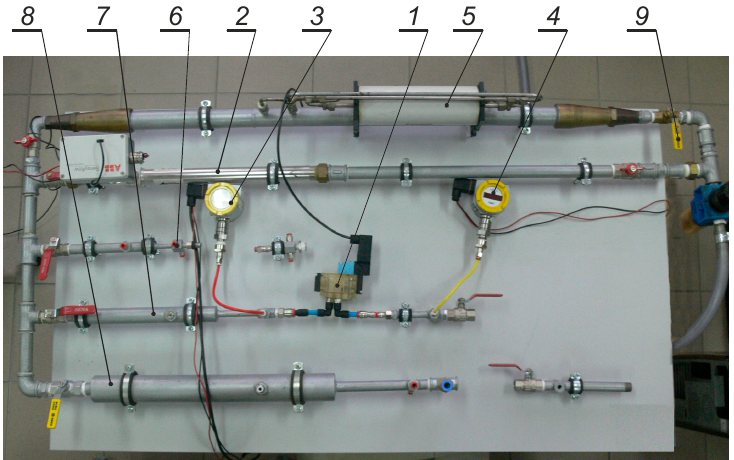
Figure 12. General view of the test stand: 1–valve tested, 2–Sensyflow D flow-rate measuring device, 3, 4–manometer, 5–U70 flow-rate measuring device, 6–measurement tube G1/8”, 7–measurement tube G¼”, 8–measurement tube G½”, 9–shut-off valve.